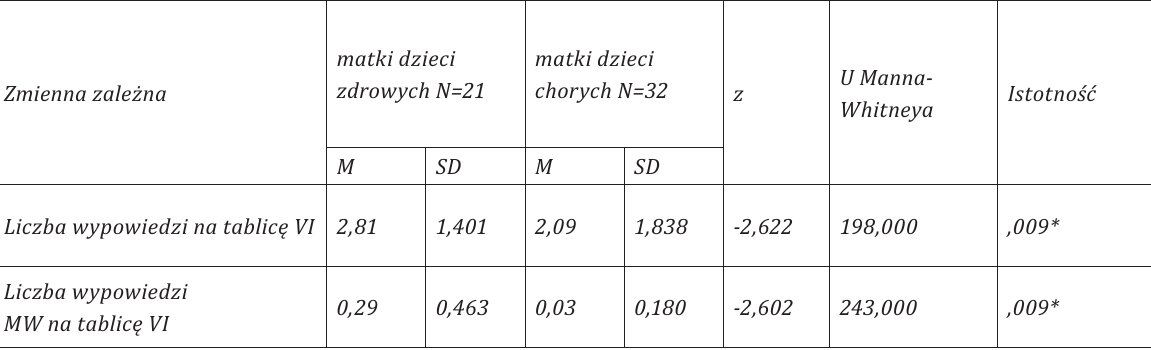
dzieci chorych a grupą ojców zdrowych dzieci, co ujęte jest w Tabeli 4. Tabela 4. Różnice i ich istotności w poszczególnych zmiennych między grupą ojców dzieci zdrowych a grupą ojców dzieci